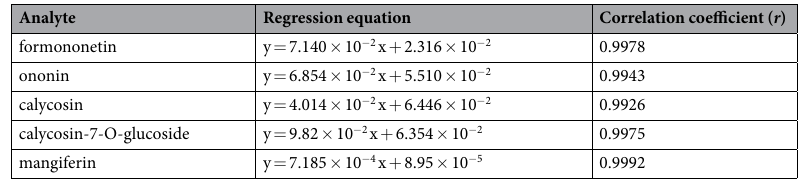
Table 2. The calibration curves of formononetin, ononin, calycosin, calycosin-7-O-glucoside and mangiferin in rat